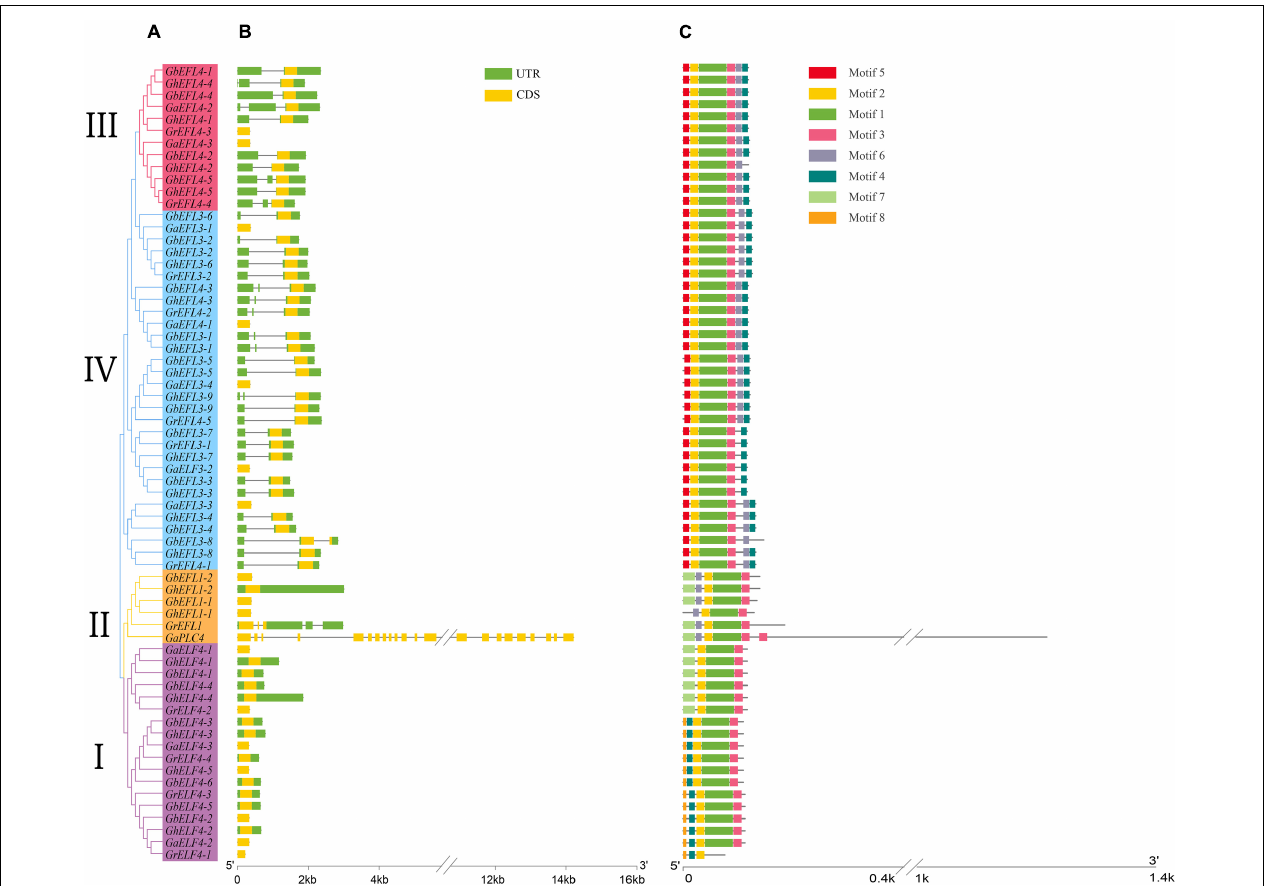
FIGURE 4 | The gene structure and conserved protein motif of four cotton species ELF4. (A) The phylogenetic tree analysis of the ELF4 gene. (B) Analysis of exons and intron in ELF4 Genes. (C) The predicted ELF4 genes motif.